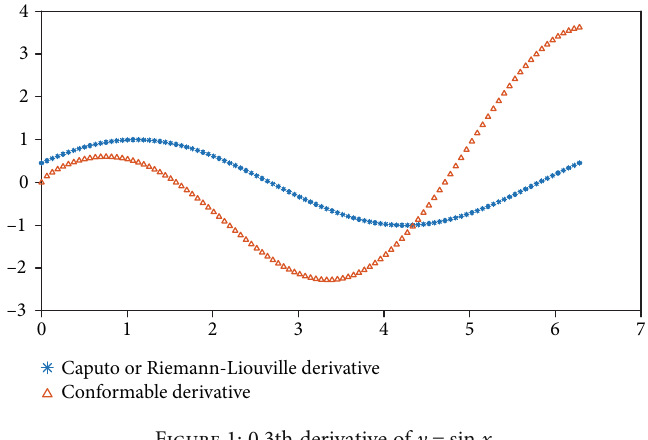
Figure 1: 0.3th derivative of y = sin x .